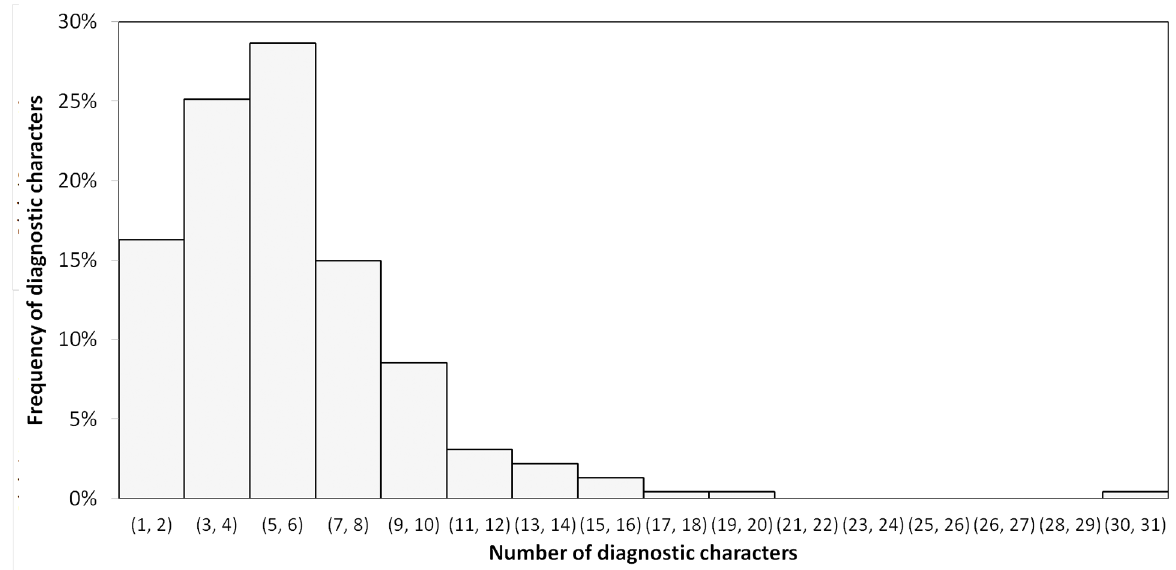
Figure 8. Frequency of characters used to diagnosis new pterosaur